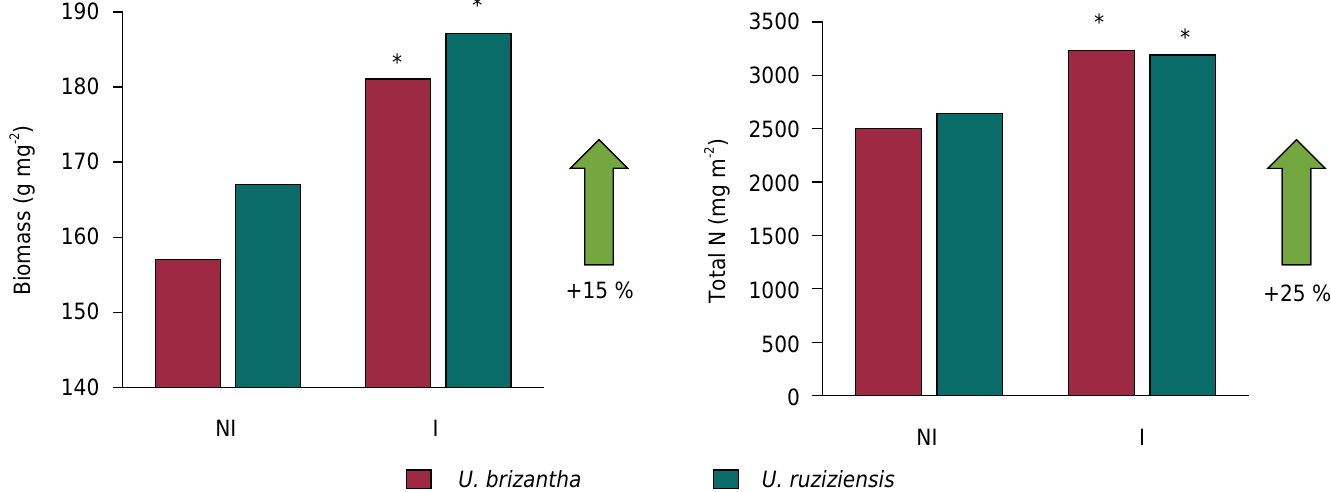
Figure 3. Shoot biomass production and total N accumulated in the biomass of Urochloa (= Brachiaria ) brizantha and Urochloa ruziziensis inoculated or not with Azospirillum brasilense strains Ab-V5 and Ab-V6; all treatments received 40 kg of N ha -1 at sowing. Asterisks denote statistical difference between inoculated and non-inoculated (p<0.05, Tukey). Data represent the means of 13 cuts, each with four replicates, in three years for each pasture species. Modified from Hungria et al.